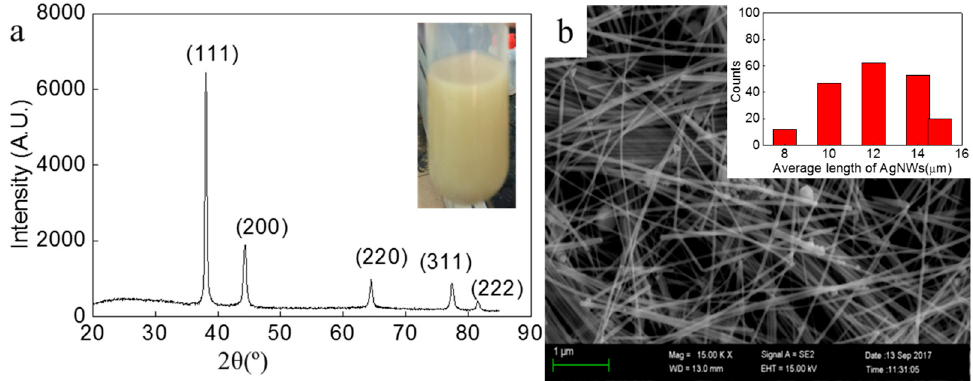
Figure 1. XRD and SEM of as-synthesized silver nanowires (AgNWs). The inserted photo in ( a ) is AgNWs solution without purification. The inserted image in ( b ) is the length distribution of AgNWs.